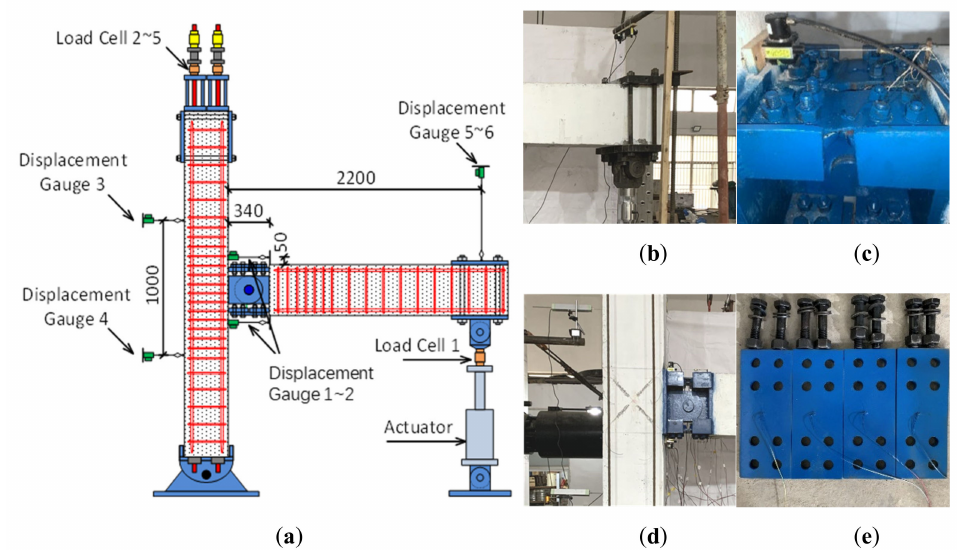
Figure 9. Location of gauges: ( a ) Overview; ( b ) Displacement Gauge 5~6; ( c ) Displacement Gauge 1~2; ( d ) Displacement Gauge 3~4; ( e ) Strain gauges of the steel